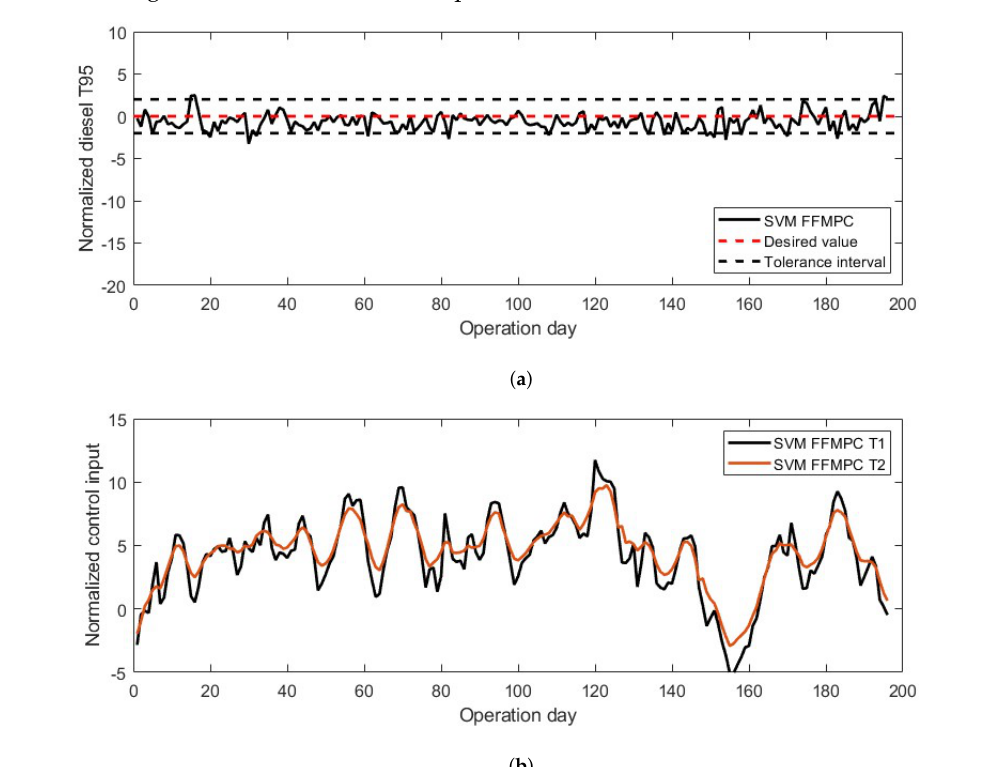
Figure 10. Diesel quality and reactor temperatures estimated with the SVM regression model. ( a ) Diesel T95 estimations. ( b ) Suggested reactor